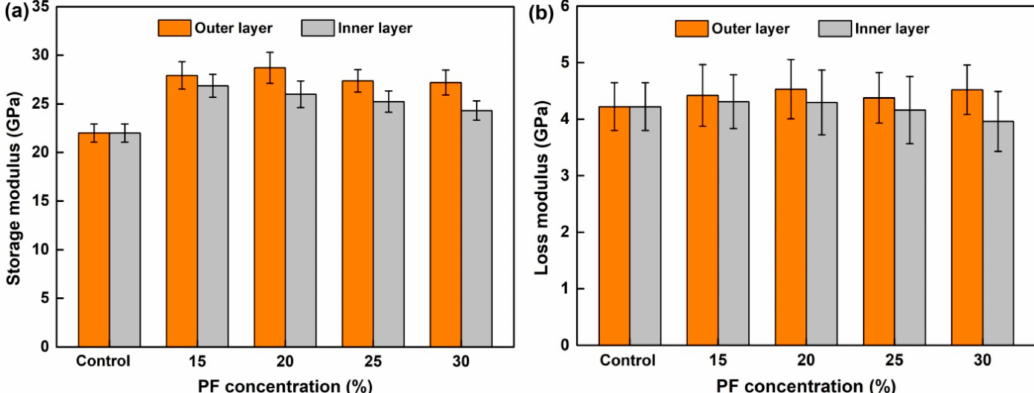
Figure 10. Profiles of storage modulus and loss modulus of PF-modified wood tracheids.